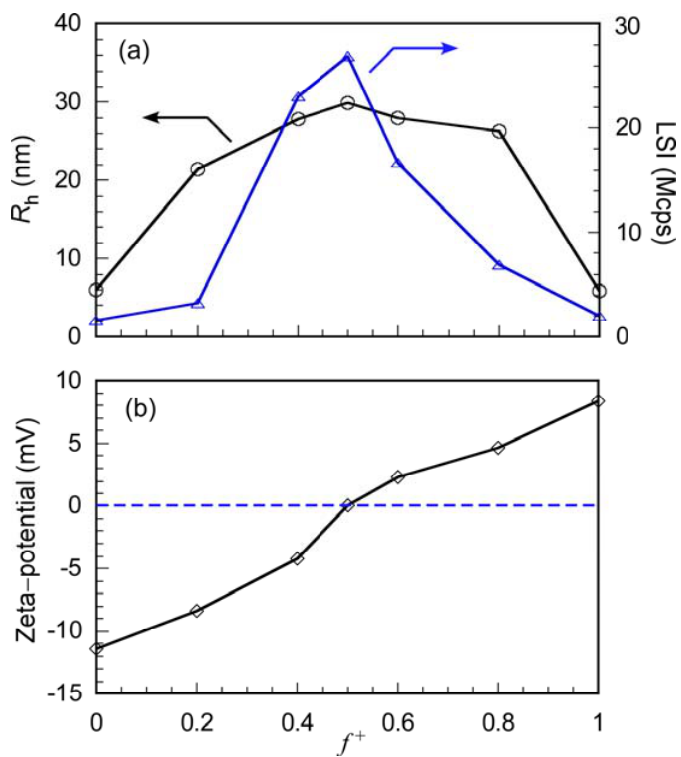
Figure 4. ( a ) Hydrodynamic radius ( R h , ○ ) and light scattering intensity (LSI, (cid:52) ) of PIC micelles as a function of f + (= [APTAC]/([APTAC] + [AMPS])) in 0.1 M aqueous NaCl; ( b ) Zeta potential of PIC micelles as a function of f + in 0.1 M aqueous NaCl.